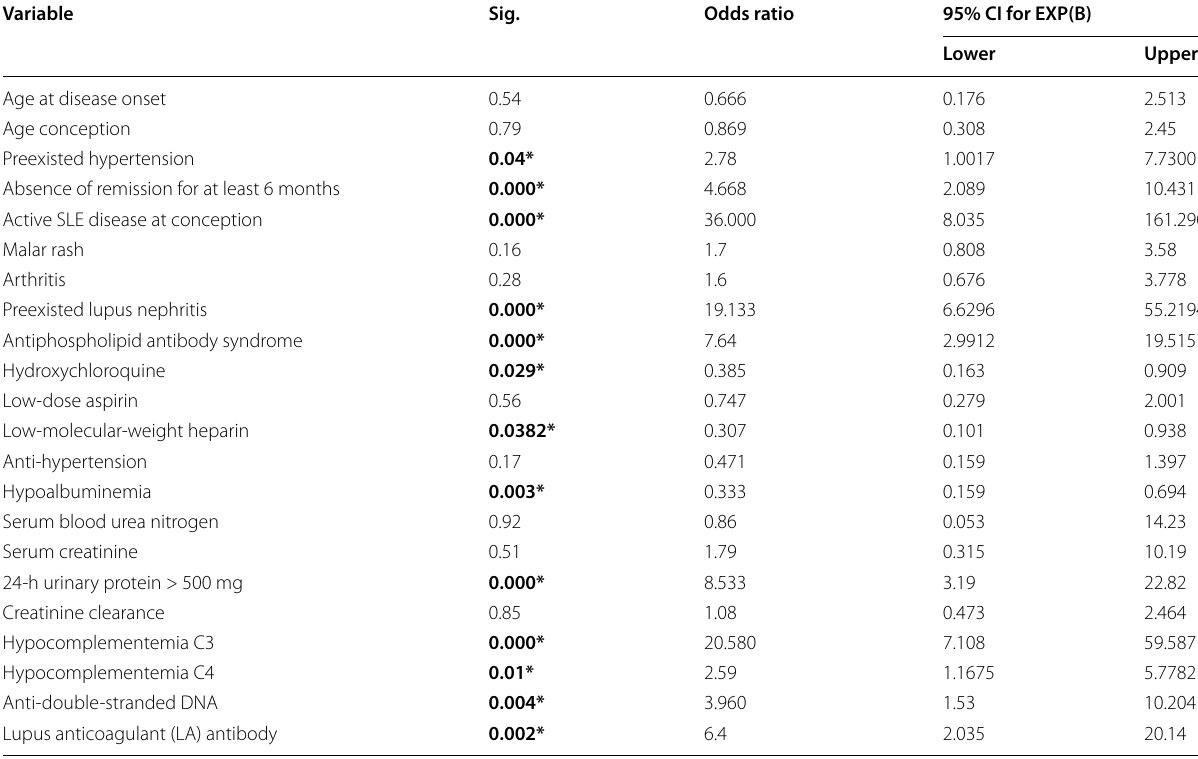
SLE systemic lupus erythematosus, CI confidence interval, OR odds ratio; insignificant, P > 0.05; significant, * P